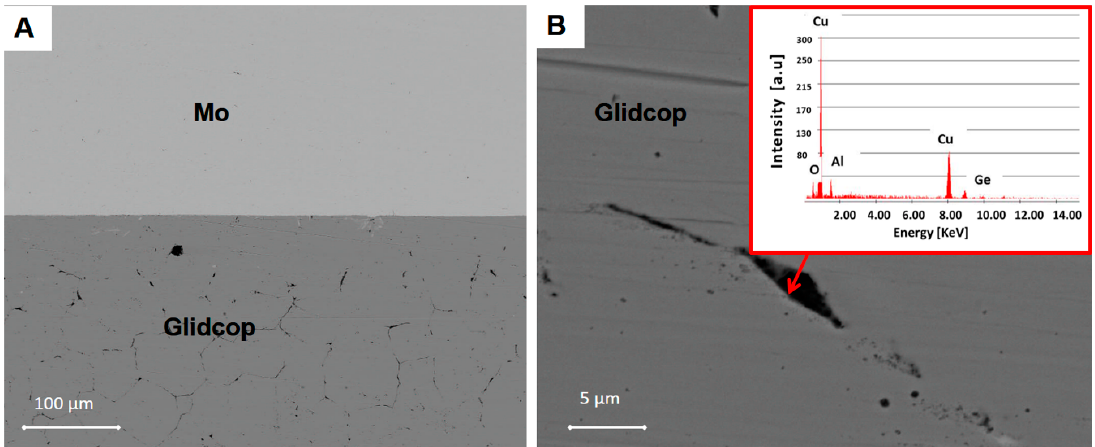
Figure 6. Scanning electron micrographs of ( A ) the cross-section of 1-µm thick Cu- plated Glidcop/Mo joint; ( B ) magnification of a grain boundary in the Glidcop and relative EDS analysis (inset) at about 150 microns from Glidcop/Gemco interface.